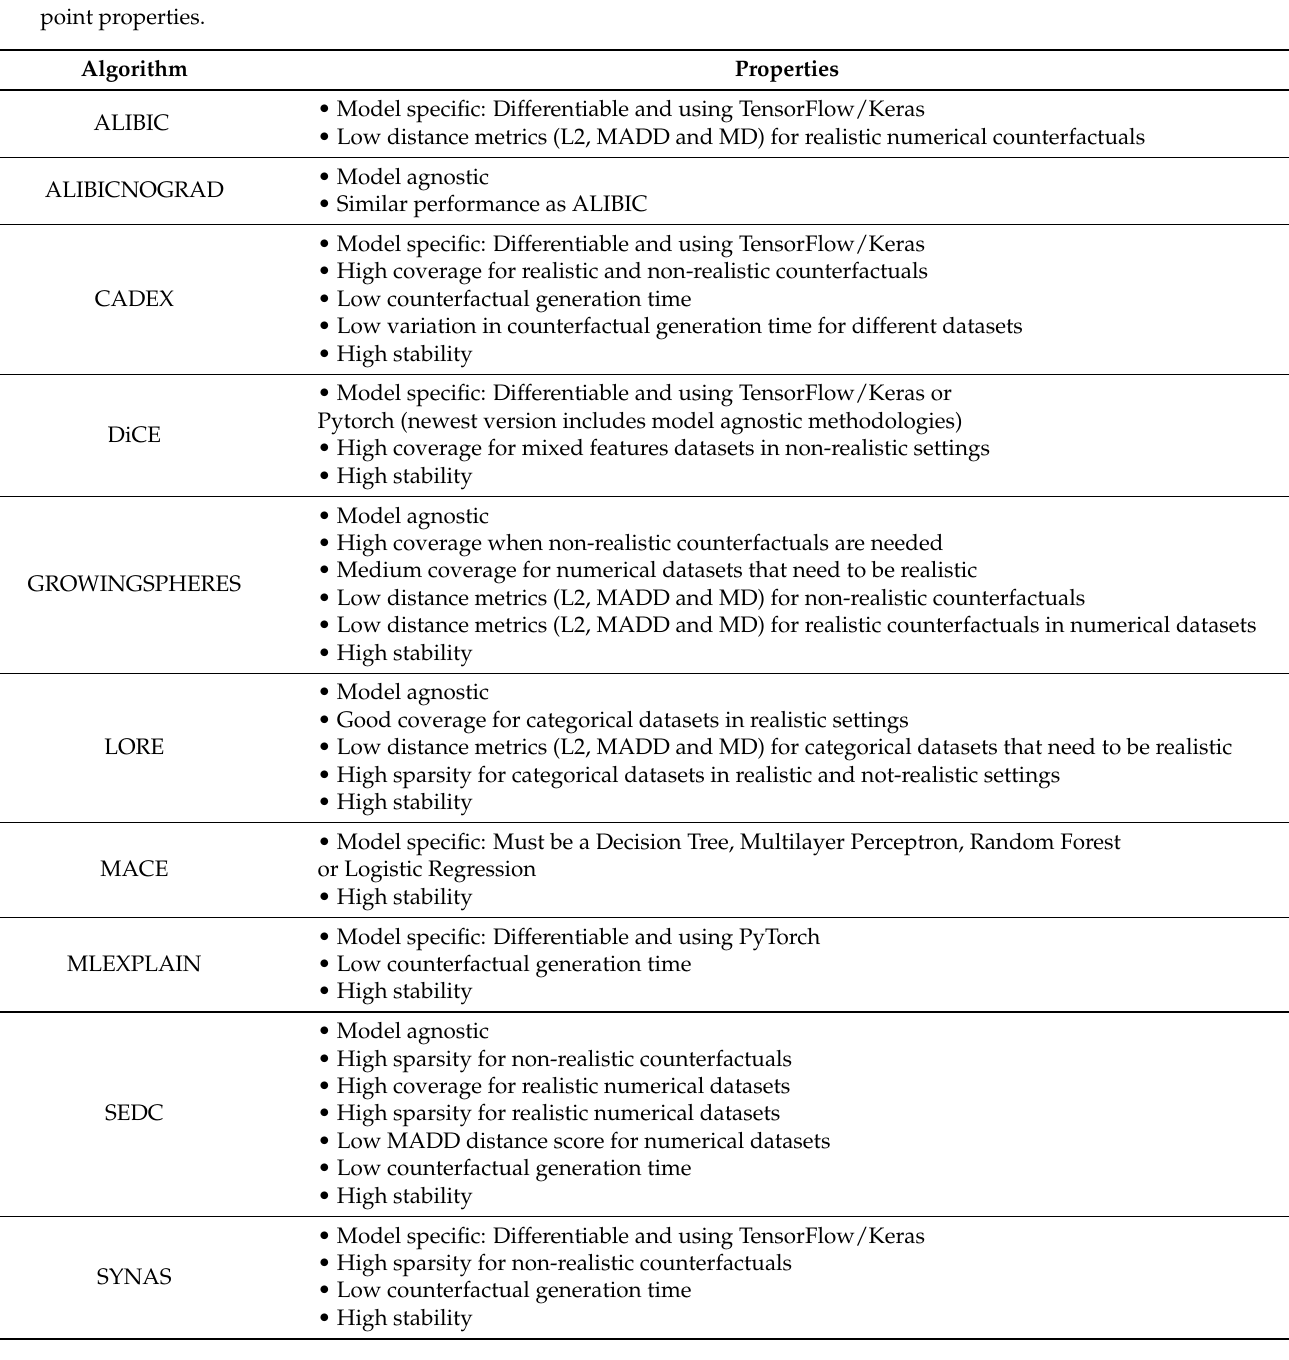
Table 6. General properties, and context in which each counterfactual generation algorithm seems to be the most suited. This table includes general instructions and, as explained in the text, may vary depending on the model, dataset, and factual point